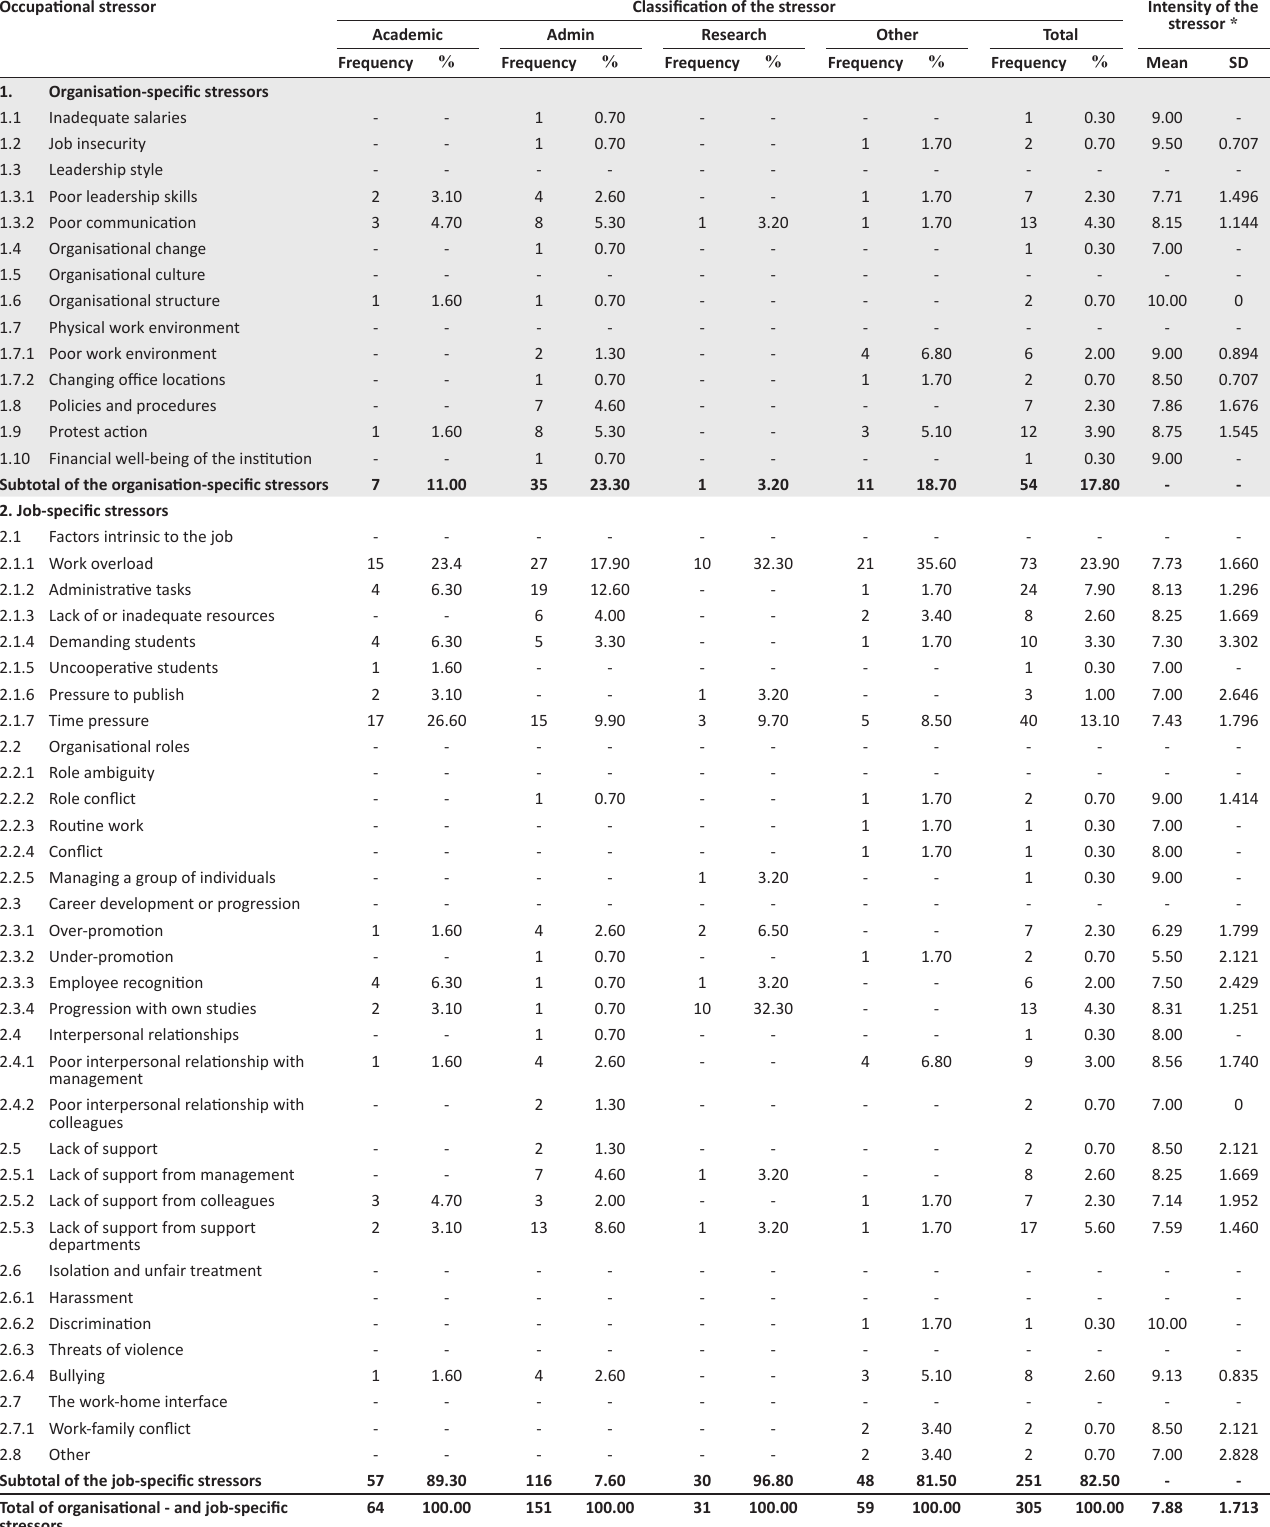
TABLE 1: Results of the thematic content